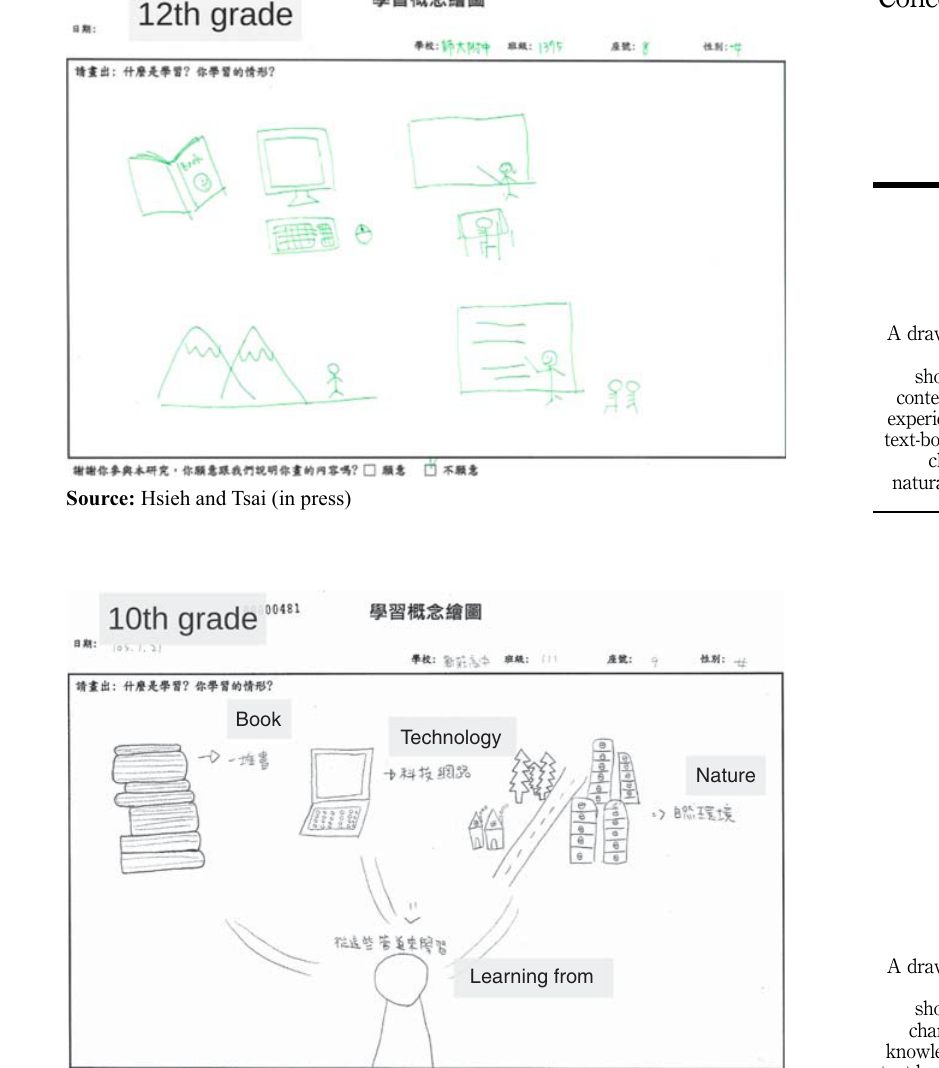
Figure 8. A drawing by a